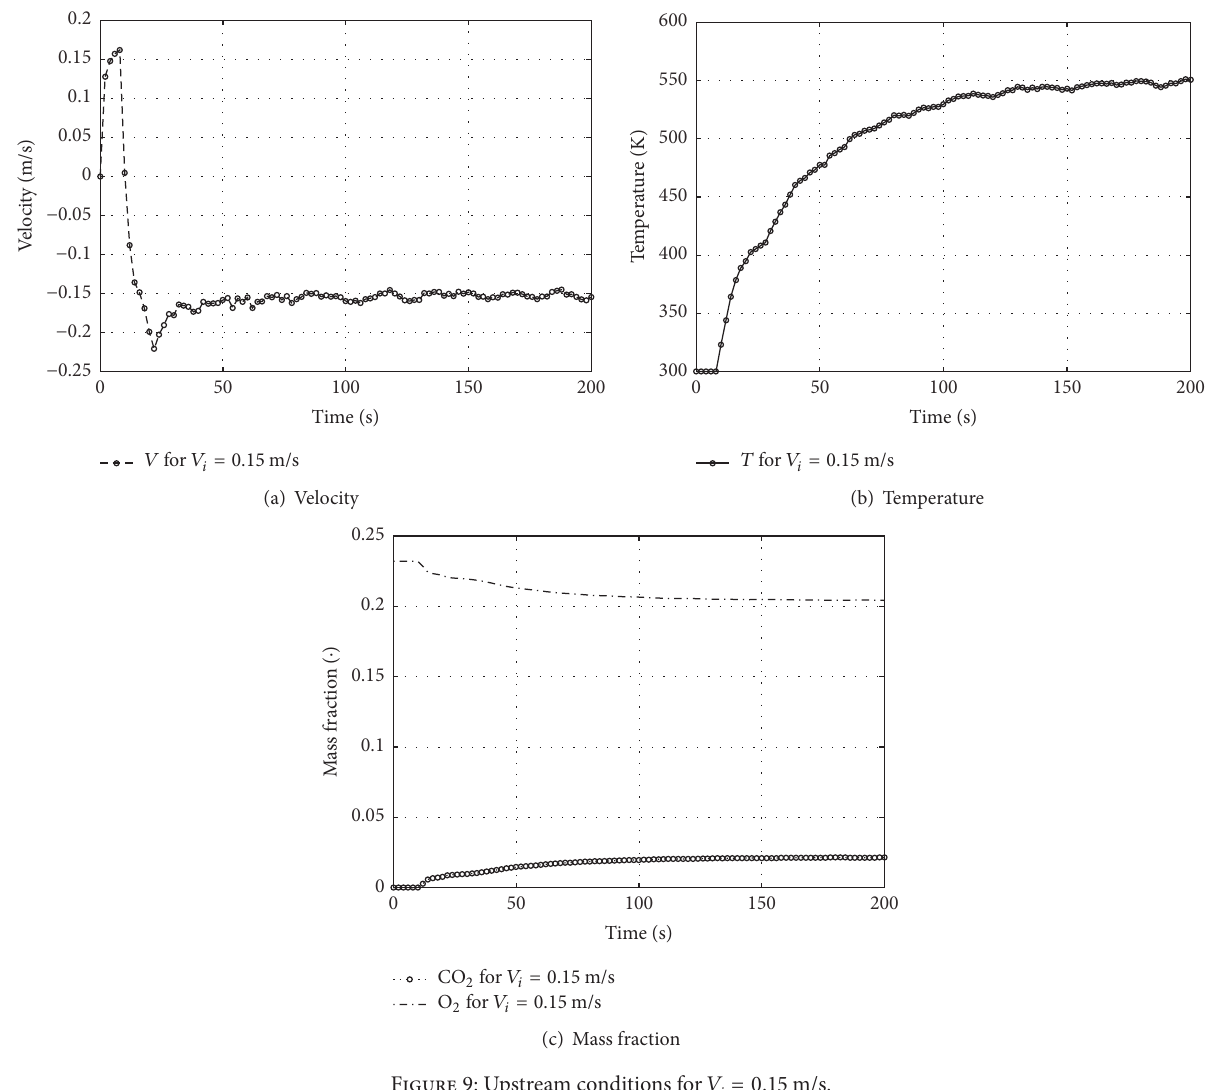
Figure 9: Upstream conditions for 𝑉 𝑖 = 0.15